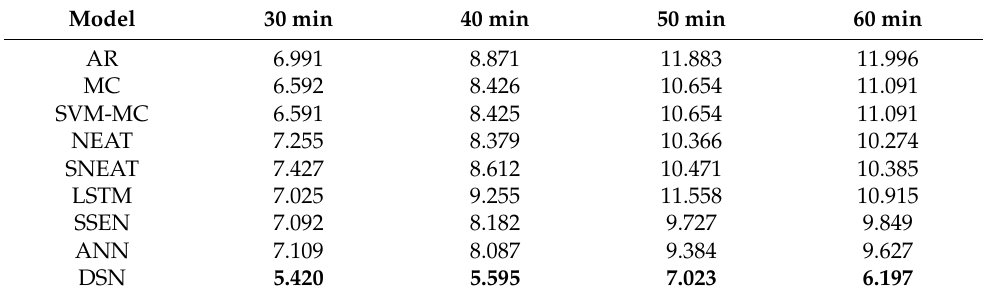
Table 4. MAE of different models at different forecasting horizons over ramp events of the year